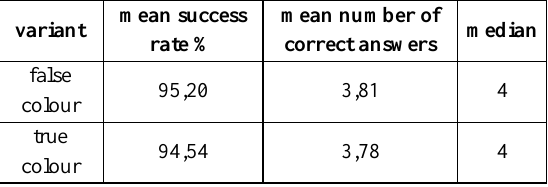
Table 1. Success - satellite data, false colour – true colour,